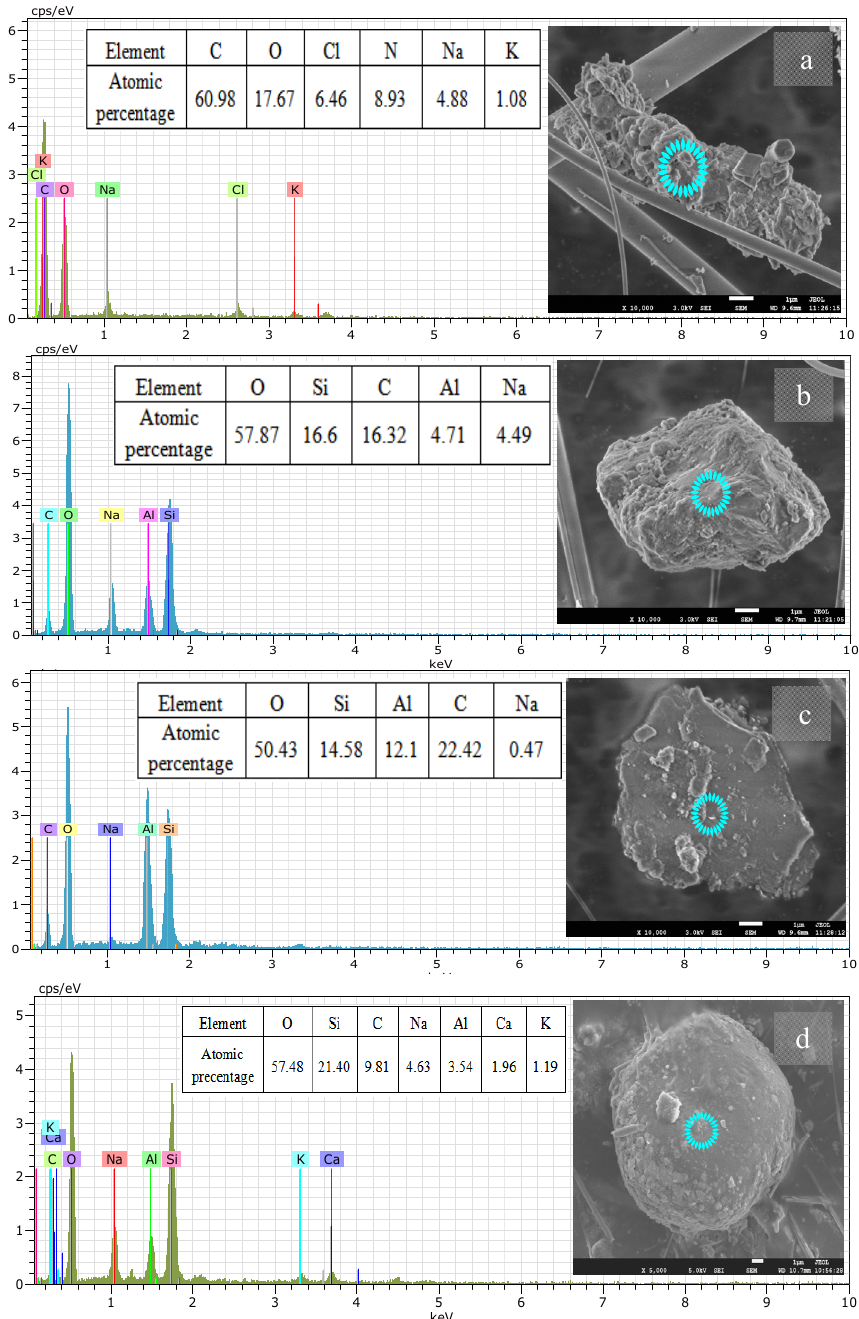
Figure 5. Element analysis of atmospheric particles in PM 10 at Wutai Mount scenic spot (( a ) in the Wu Ye Temple sampling point; ( b ) in the Manjusri Temple sampling point; ( c ) in the Yang Bai Lin Village sampling point; ( d ) in the Nan Shan Temple Forest District sampling